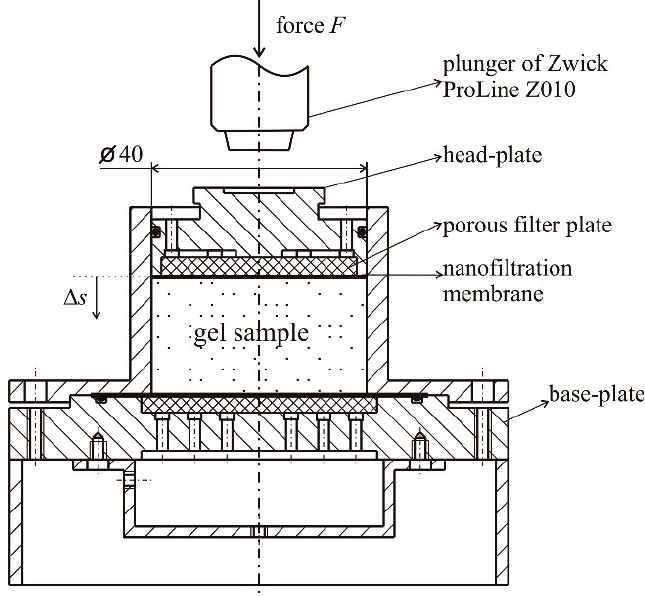
Figure 5. The setup of the measuring cell for enforced syneresis (after